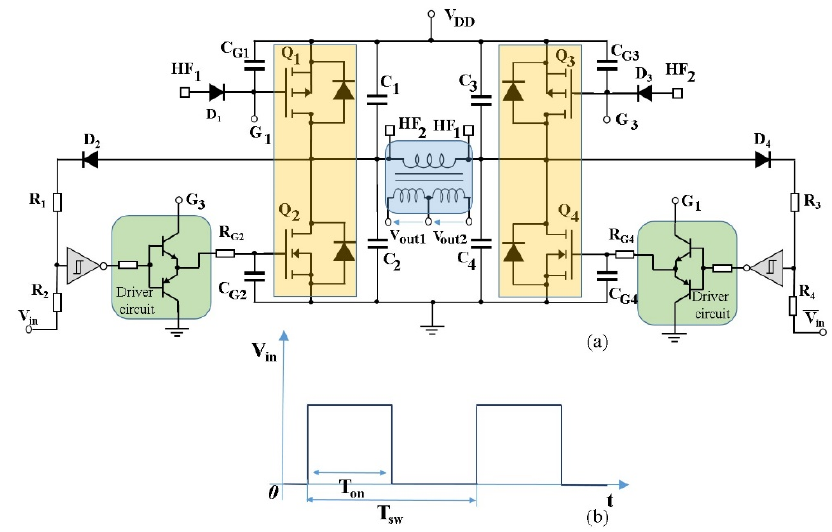
Figure 5. ( a ) Schematic of soft-switching full bridge with complementary power MOSFETs in the switching leg and innovative driving solution. ( b ) 50% of duty cycle PWM voltage control signal.